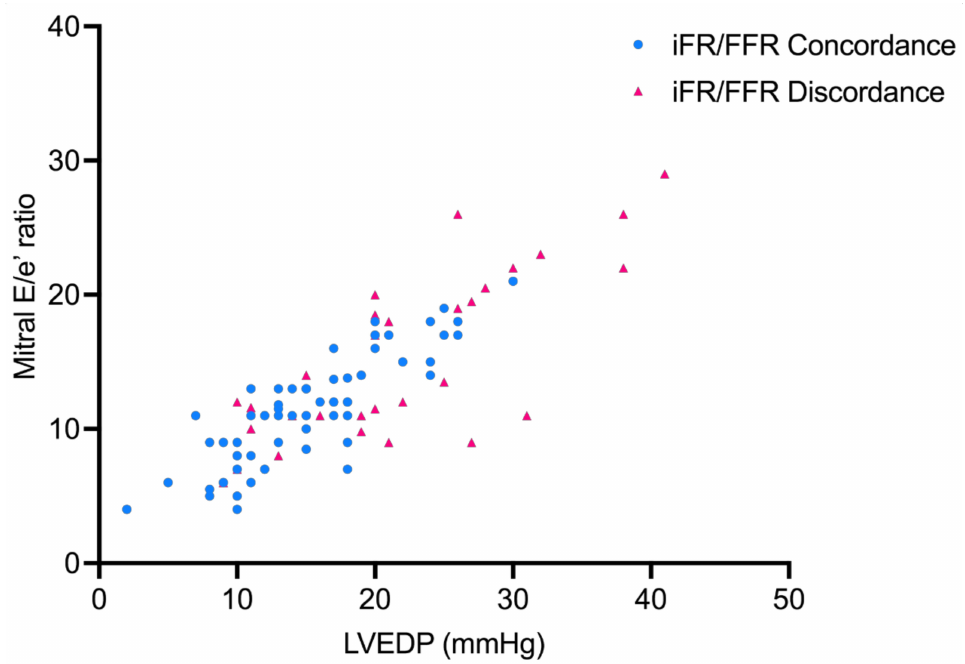
Figure 2. Scatter plot showing correlation between LVEDP and mitral E/e ratio in patients with iFR/FFR concordance and discordance. iFR: instantaneous wave-free ratio; FFR: fractional flow reserve; LVEDP: left ventricular end diastolic